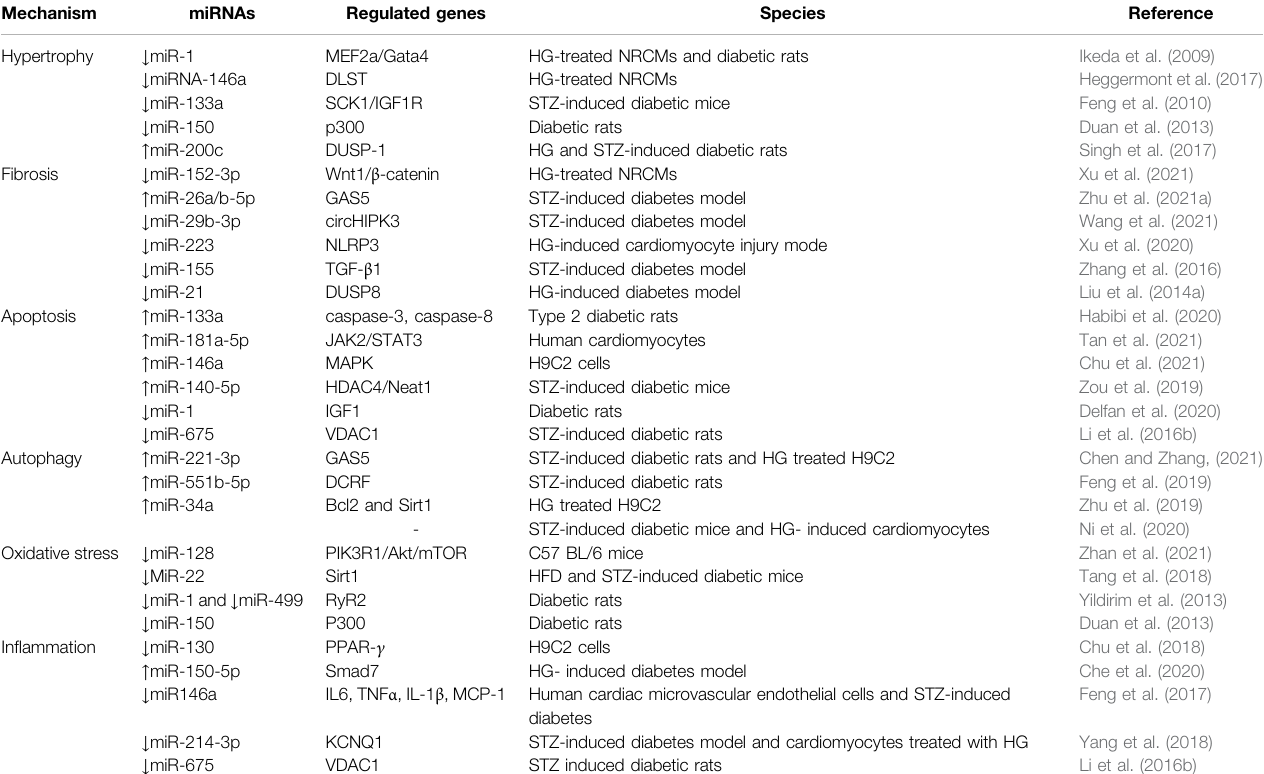
TABLE 2 | Summary of miRNAs involved in the pathogenesis of DCM.